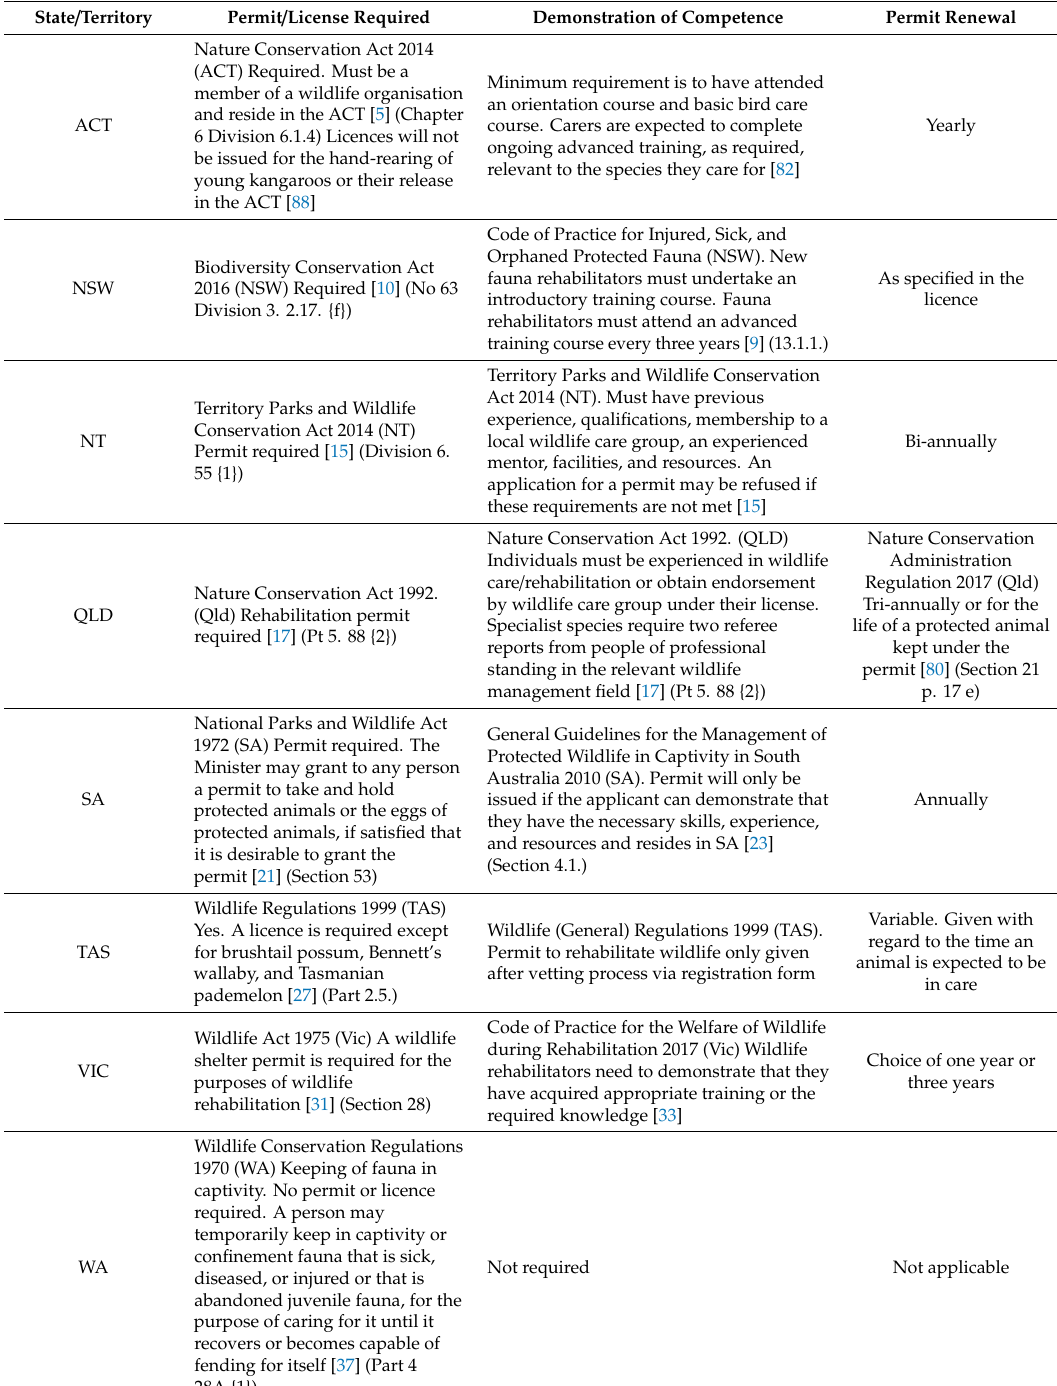
Table 3. Australian licensing, permitting, and training requirements for wildlife carers to keep wildlife. State /